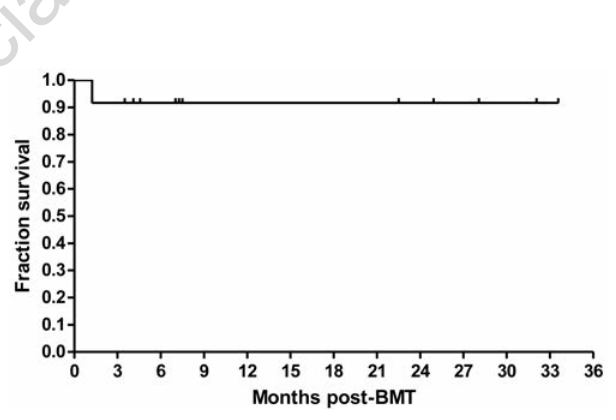
Figure 1. Thalassemia-free survival